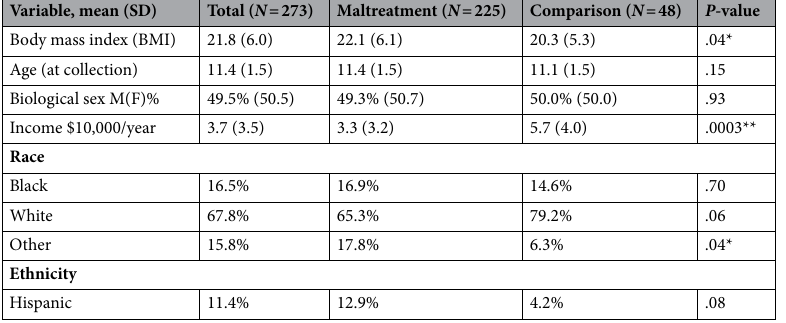
Table 1. Summary demographics for analytic sample. † P < .10, * P < .05, ** P < .01, *** P < .0001.